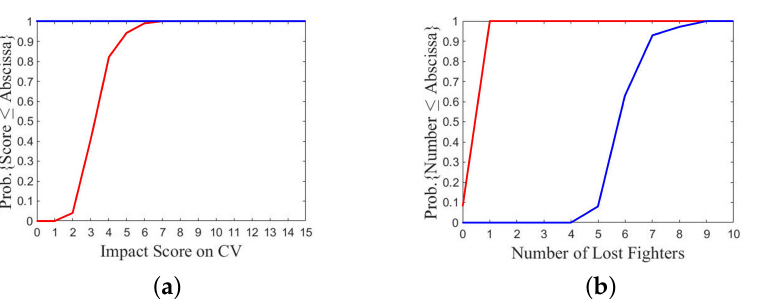
Figure 10. Cumulative distribution of payoff, ( a ) A1/B2, ( b ) A1/B3, with one P 2 SO run over 100 games, ———: fleet A, ———: fleet B.